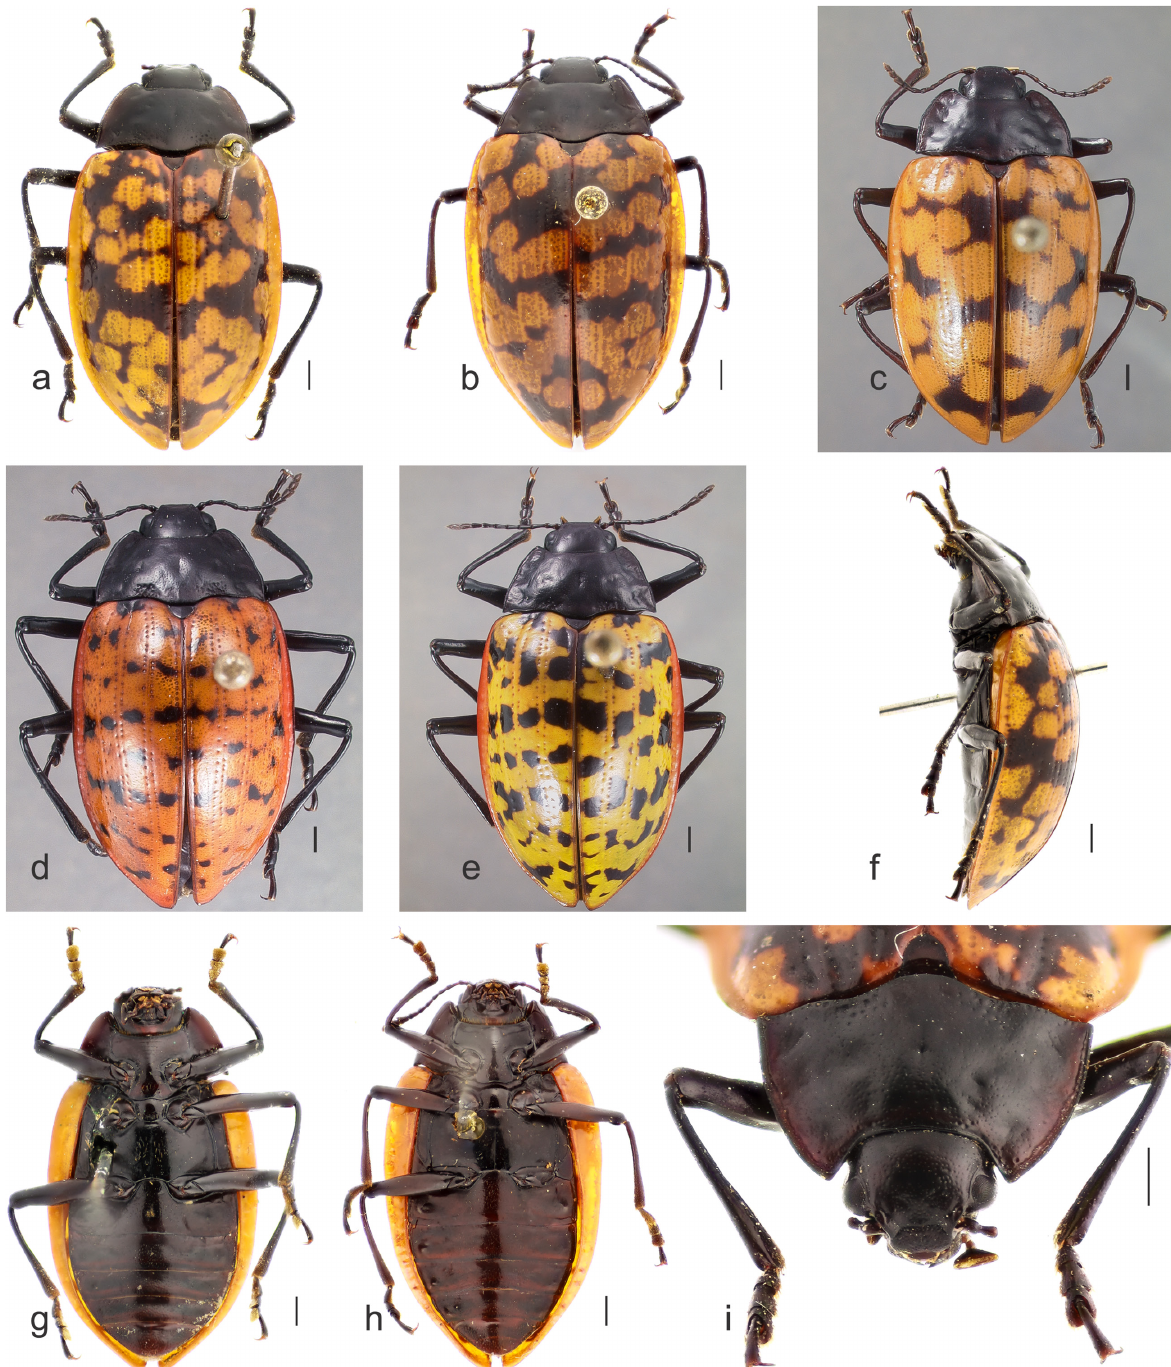
Figure 2. Specimens of Erotylina leoparda (Lacordaire, 1842) from different localities. a–e. Dorsal view: A. Male from Jalapa (Mexico) (DZUP); b. Female from Cordoba (Mexico) (DZUP); c. Male from Ocotal Chico (Mexico) (FSCA); d. Male from Guanacaste (Costa Rica); e. Male from Braulio Carrillo National Park (Costa Rica) (FSCA). f. Lateral view of the specimen from Jalapa. g–h. Ventral views of the specimens from Jalapa and Cordoba, respectively. i. Pronotum and head of the specimen from Jalapa. Scale bars: a–i = 1